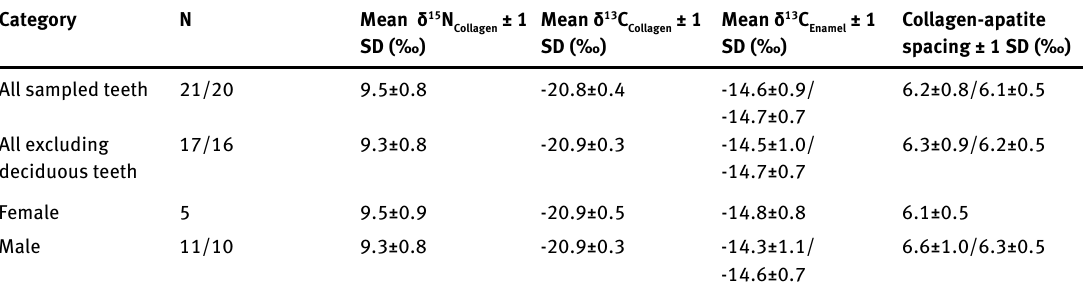
Table 4. Summary statistics of light stable isotope data from Falköping stad 5, with and without the outlier (collagen apatite spacing)